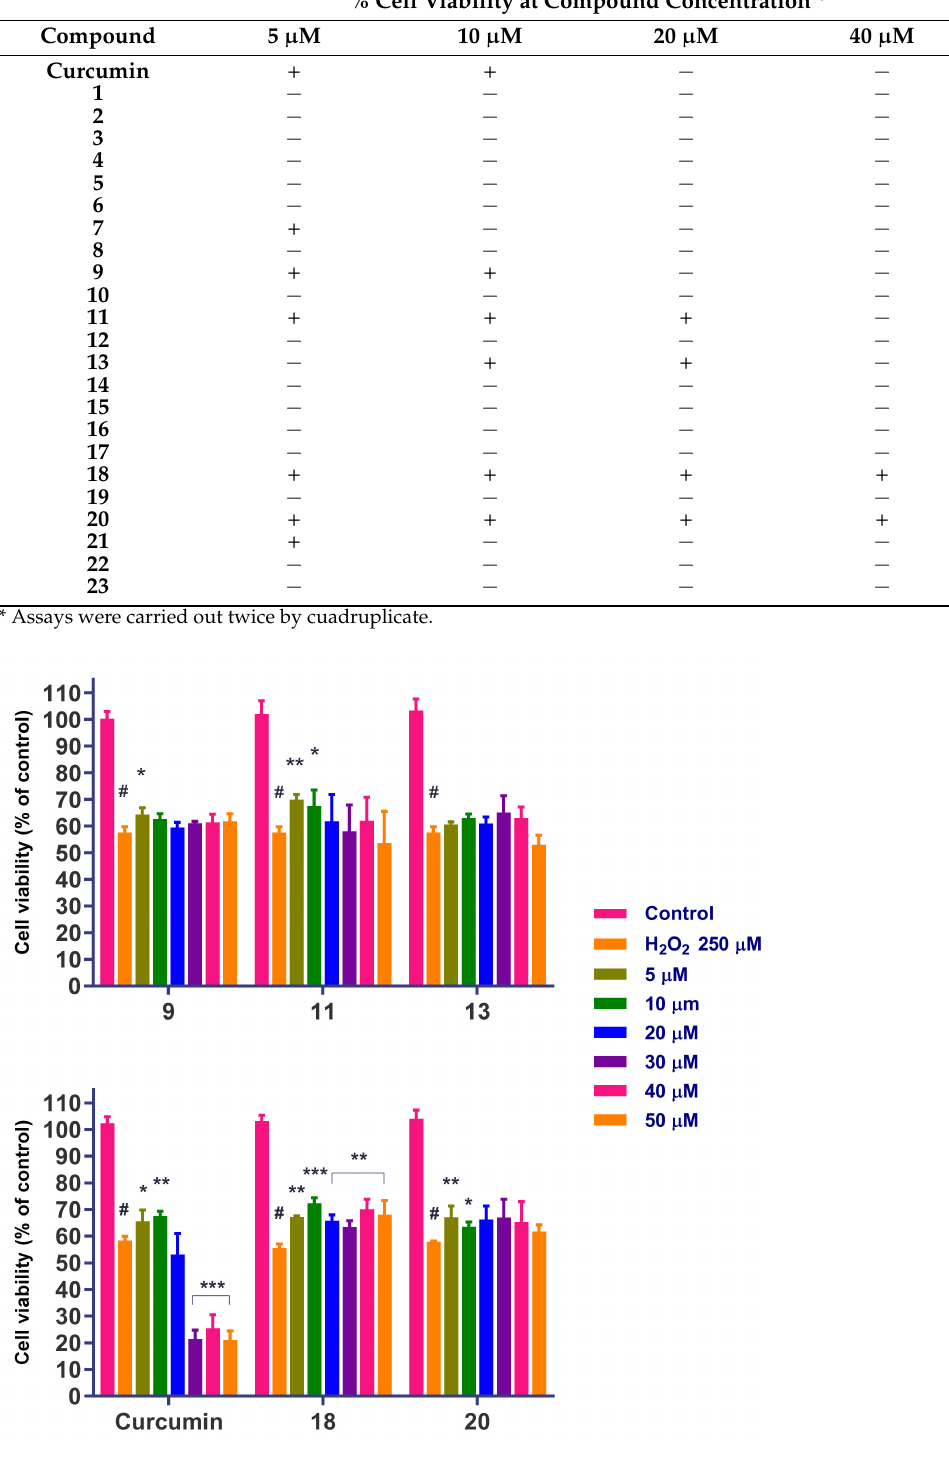
Figure 8. Neuroprotection effect of compounds 9 , 11 , 13 , 18 , 20 , and curcumin against H 2 O 2 -induced cytotoxicity in SH-SY5Y cells. Cell viabilities were determined by MTT assay. Compounds were administered at different concentrations for 24 h prior to treatment with H 2 O 2 250 µ M for another 24 h. Data are presented as the Mean ± SEM of four independent experiments carried out in